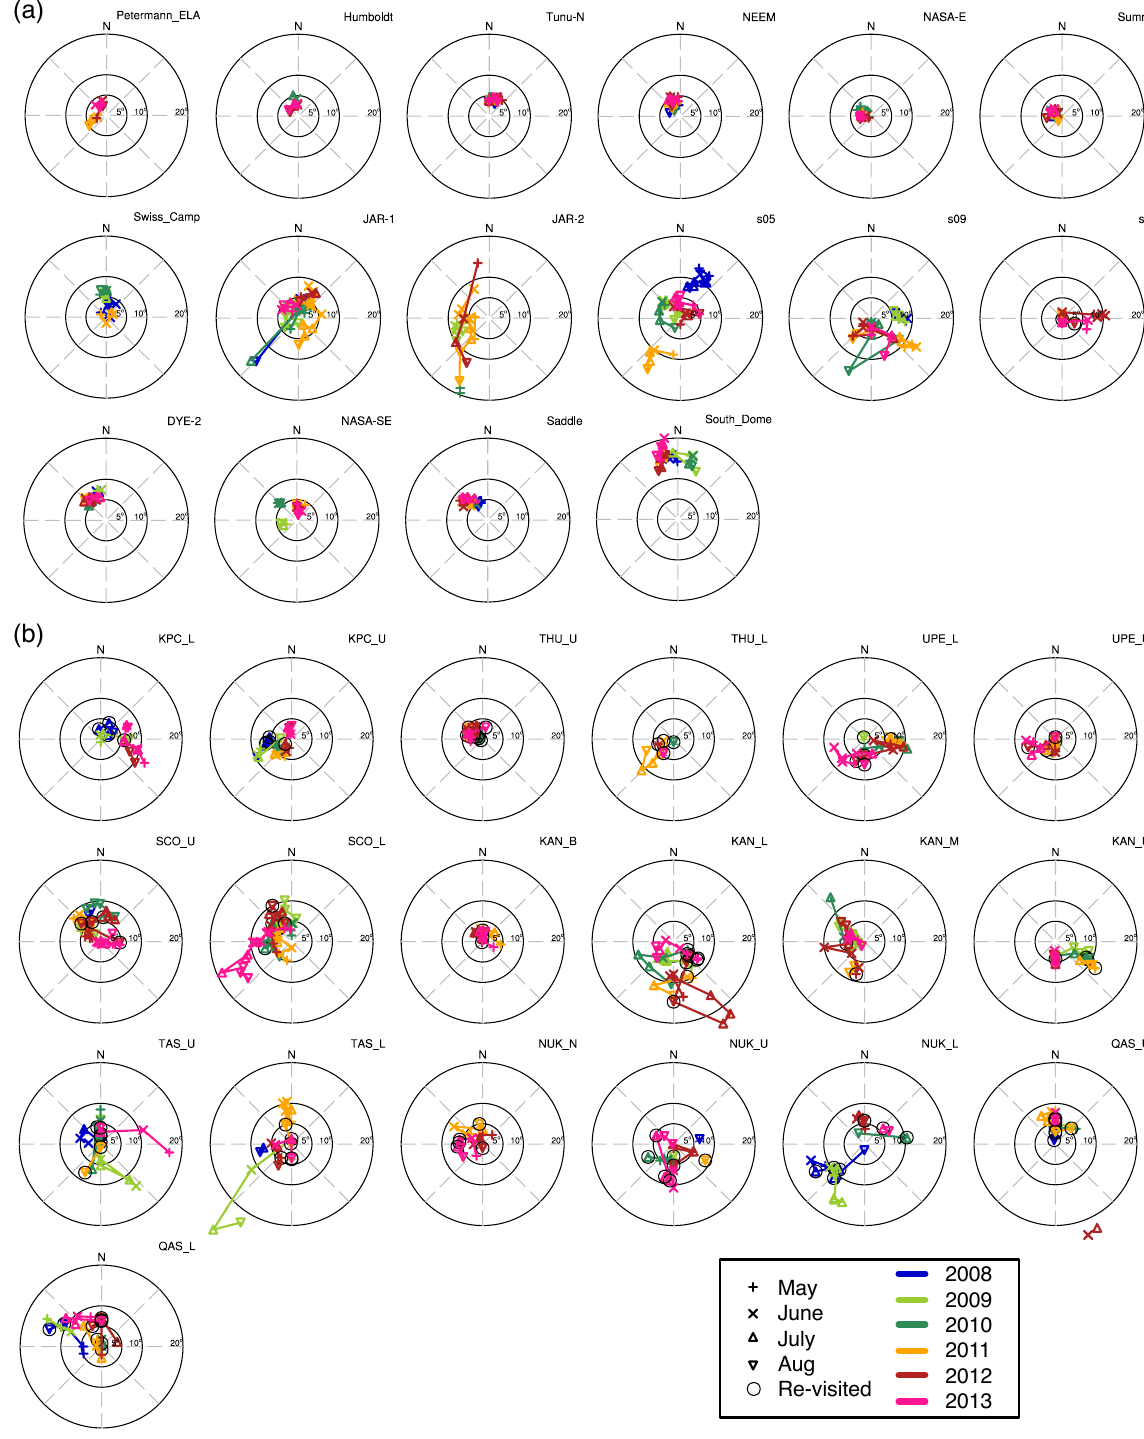
Figure 8. Station tilt angles (represented by the distance from the circle center) and tilt directions (0 ◦ points to the South) of (a) GC-Net and K-transect; (b) PROMICE. The markers are circled in black if the stations were re-visited in those months (no re-visiting record for GC-Net is found). There might be multiple tilt angles in 1 month. The panels of stations on each sub-figure are arranged in the order of latitude, from north to